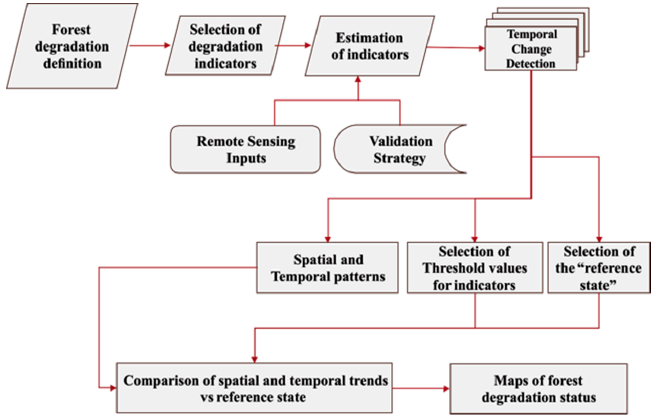
Figure 2. Methodological path to monitor and assess forest degradation in a dry semi-deciduous forest.